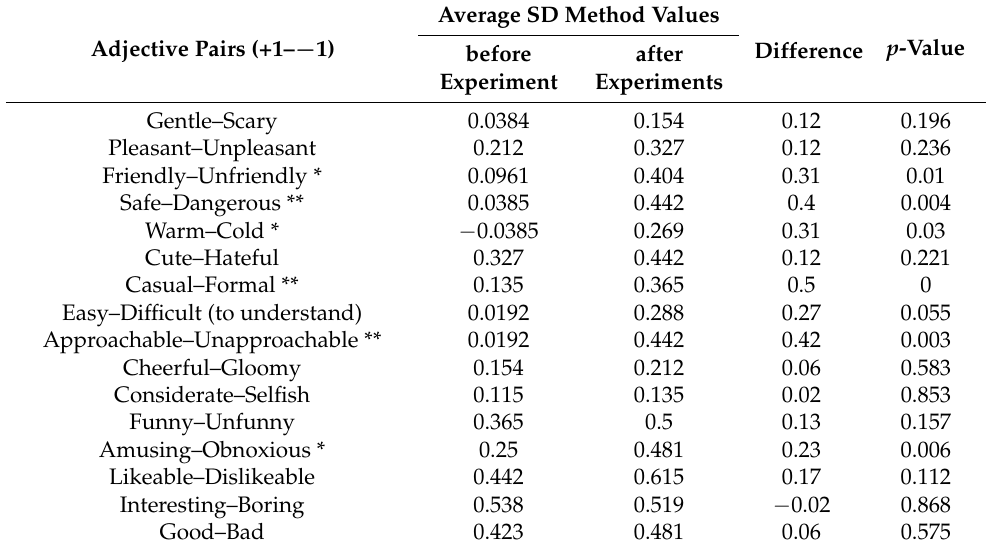
Table 8. Result of SD questionnaire (**: p -value < 0.005, *: p -value <